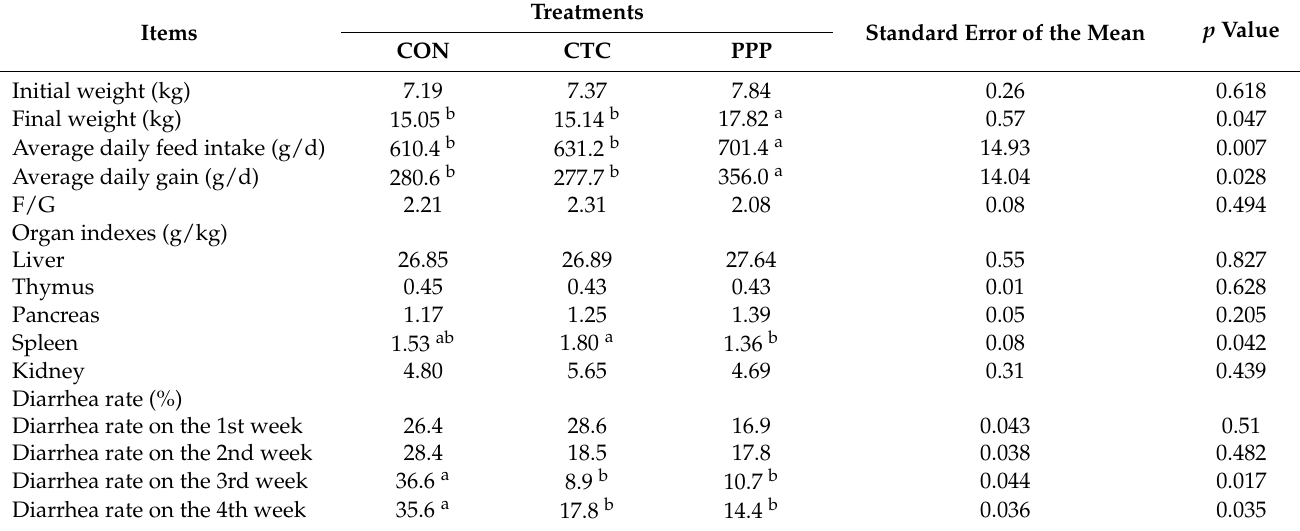
Table 2. Dietary pomelo peel powder affected growth performance, diarrhea rate, and organ index of